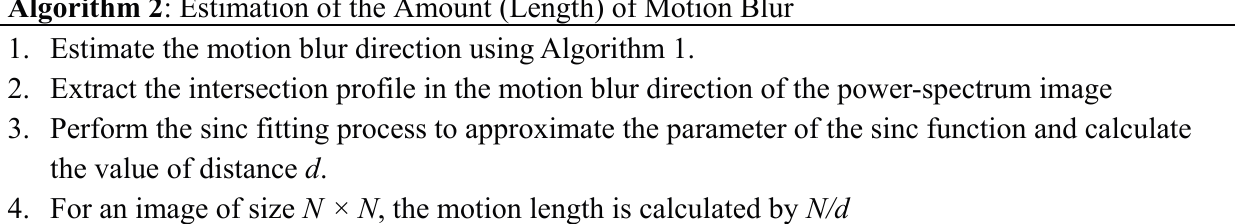
Algorithm 2 : Estimation of the Amount (Length) of Motion Blur